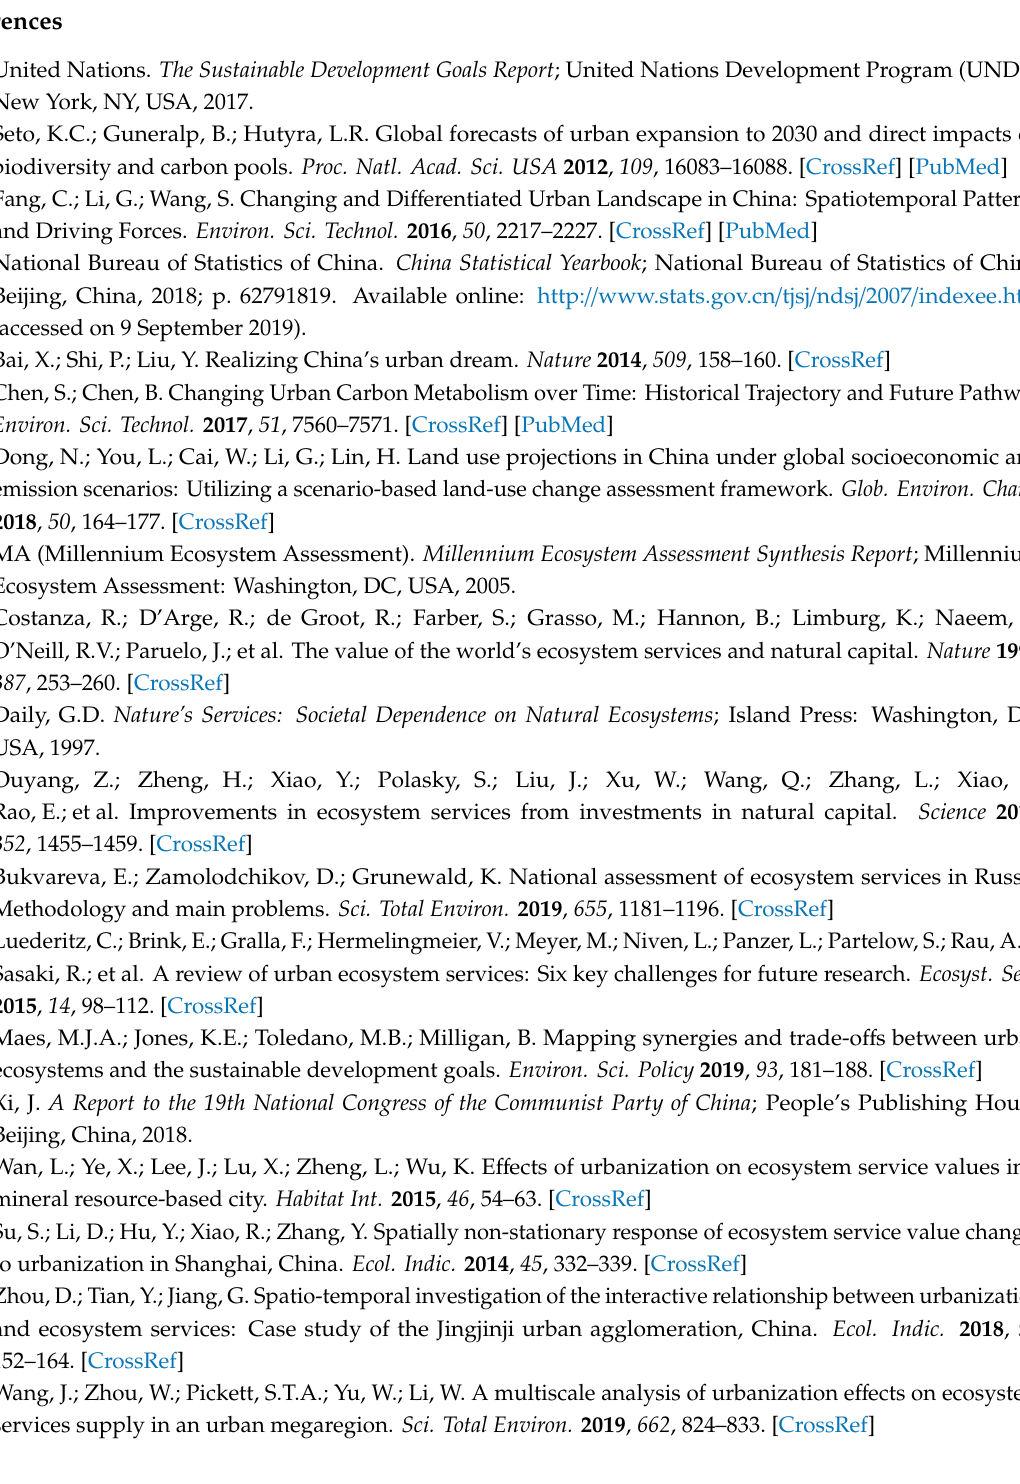
6. Runo ff , geopotential energy (J) = (land area)(% runo ff )(rainfall)(avg elevation)(gravity) % − 2 runo ff = 25%; Gravity = 9.8 m s . 7. Runo ff , chemical potential (J) = (land area)(rainfall)(% runo ff )(Gibbs energy of runo ff ) % − 1 runo ff = 25% [66]; Gibbs energy of runo ff = 4.70 × 10 3 J kg [66]. − 1 8. Wave Energy (J) = (shore length)(1 / 8)(density)(gravity)(wave height 2 )(velocity)(3.14 × 10 7 s y ) − 1 − 1 shore length of Shanghai = 213.05 km [85]; Wave height = 5.00 × 10 m; Velocity = 5.42 m s